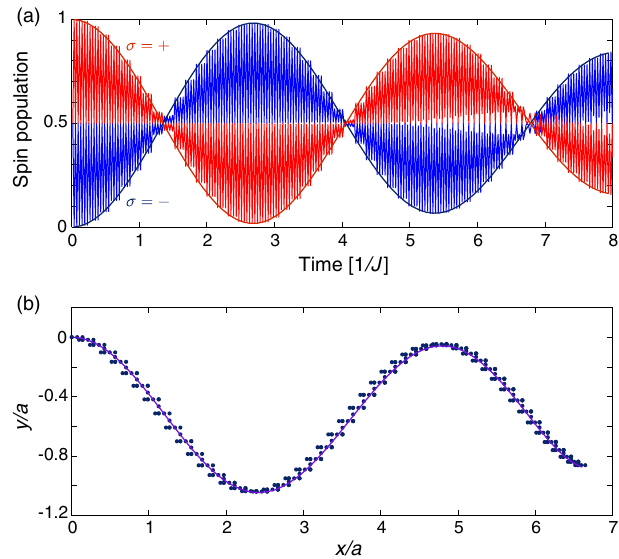
FIG. 6. The xy scheme: dynamics of the driven system associated with the driving sequence (51). Here, κ ¼ 80 J=a and T ¼ π = 20 J − 1 , which corresponds to the special regime π = 2 Þ aJ . (a) Spin populations as a function of time. where λ R ¼ ð Bold (respectively, thin) lines correspond to the predictions of the effective Hamiltonian in Eq. (66) (respectively, to the real dynamics of the pulsed system). (b) Center-of-mass displacement in the x - y plane after a time t ¼ 8 =J . The blue dots (respectively, purple line) correspond to the real dynamics of the pulsed system [respectively, to the effective Hamiltonian in Eq. (66)]. In both figures, the real dynamics are sampled using the time step Δ t ¼ T= 8 to highlight the micromotion, which is not captured by the effective